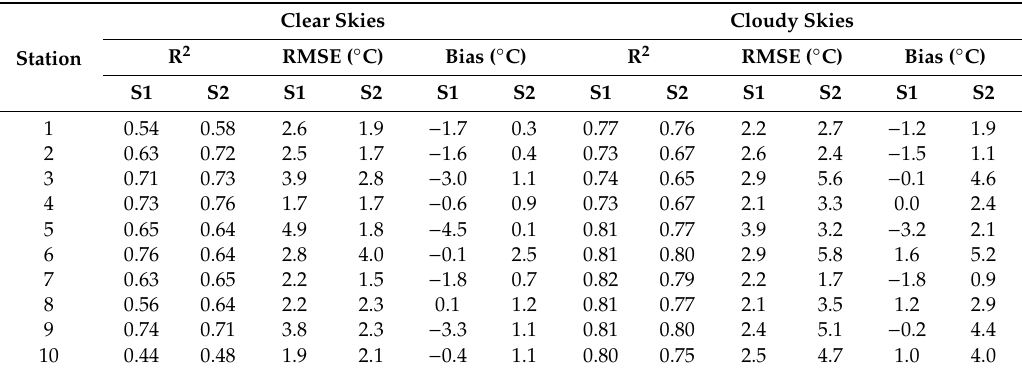
Table 3. The leave one-station out cross-validation (LOOCV) results of the estimated 1 km clear and cloudy sky LSTs from scheme 1 (S1) and scheme 2 (S2) using bias-corrected in situ LSTs at 10 stations during July and August from 2013 to 2018 for daytime. Refer to Figure 1 for station numbers.